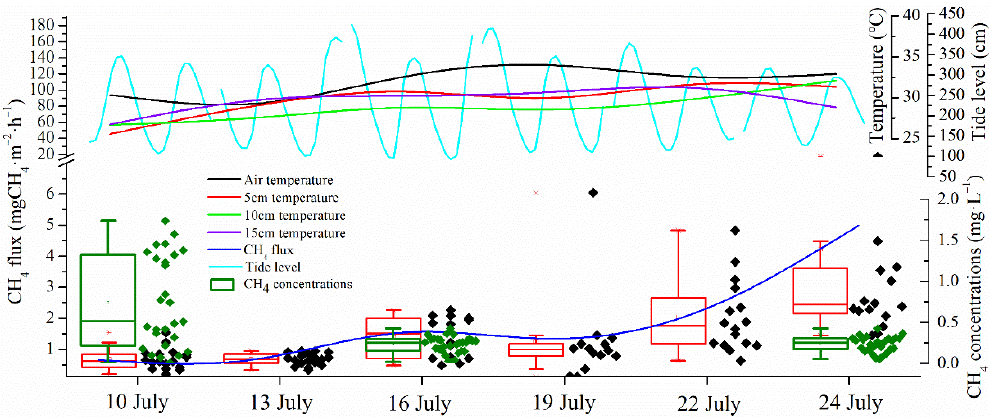
Figure 5. Schematic diagram of the main controlling mechanisms of short-term CH 4 emissions in the studied area.